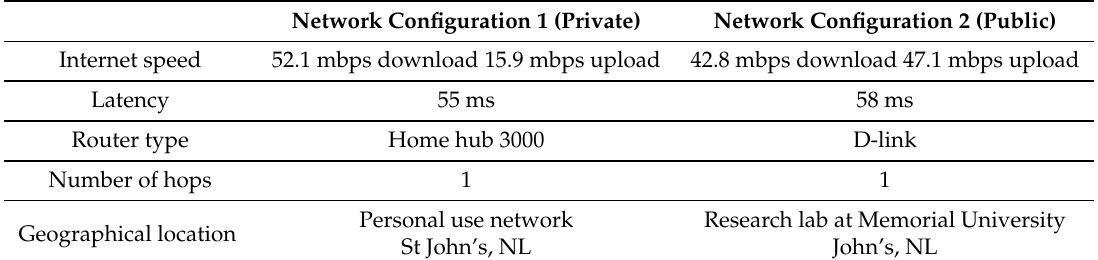
Table 2. Network configuration